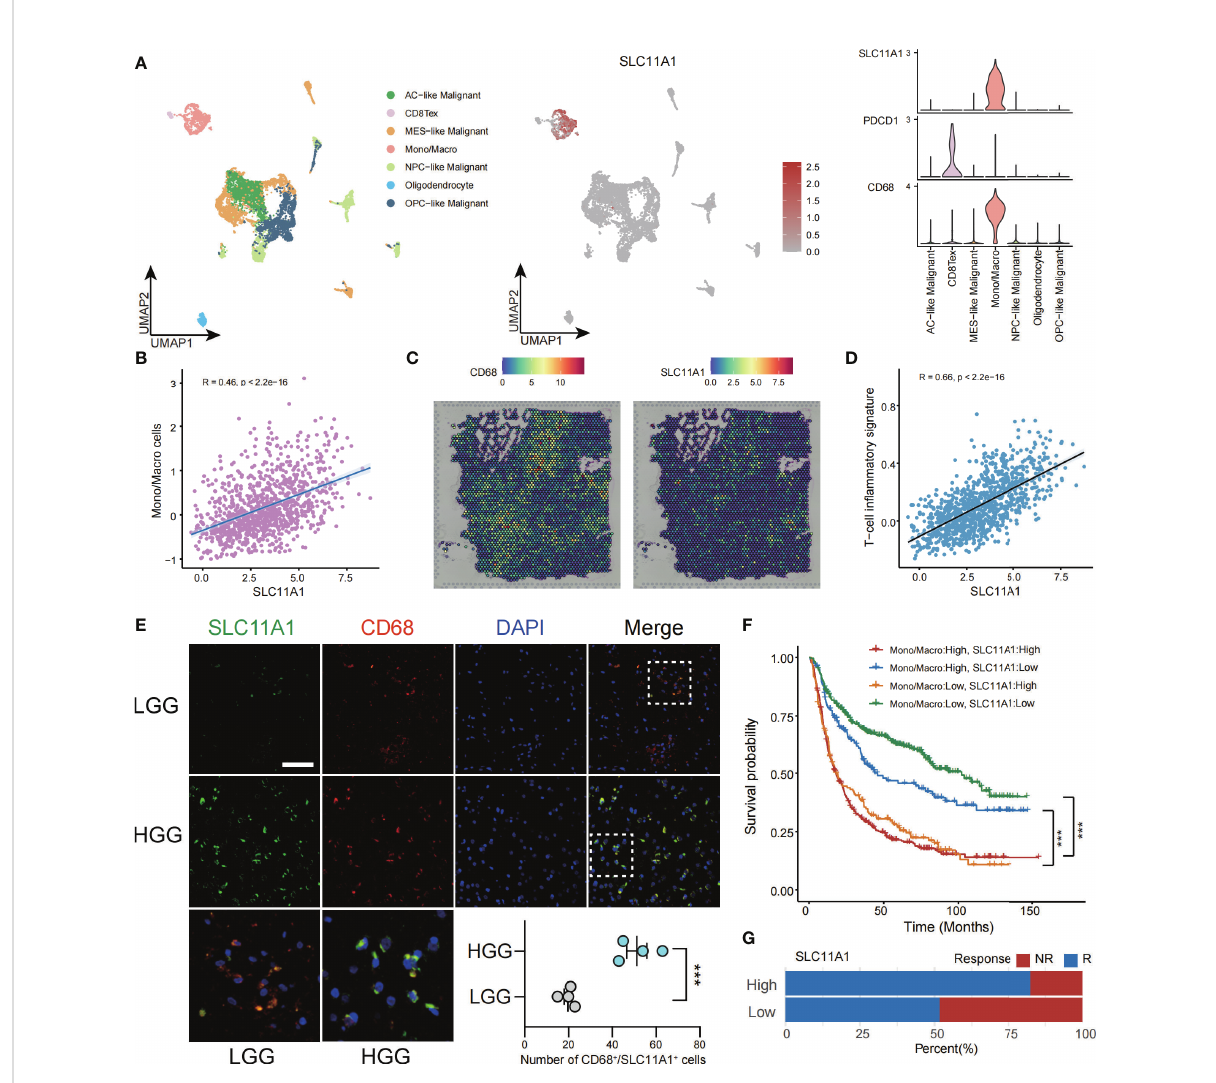
FIGURE 6 SLC11A1 expression implies TME in gliomas. (A) Analysis of immune cell in fi ltration and SLC11A1 ’ s speci fi c expression through single cell data of gliomas. (B) Correlation between the SLC11A1 ’ s expression and Mono/Macro cells (C) Analysis of SLC11A1 ’ s location in gliomas based on spatial transcriptome. (D) Correlation between the SLC11A1 ’ s expression and T-cell in fl ammatory signature. (E) Representative immuno fl uorescence images of human glioma samples co-stained with PDCD1 or CD68 (red) and SLC11A1 (green) in LGG and HGG. (F) Kaplan-Meier plots were performed in context of monocytes/macrophages in fi ltration and SLC11A1 expression. ***,P < 0.001 (Wilcoxon test). (G) Rates of anti-PD1 responses of patients from the CGGA cohort in the high or low SLC11A1 subgroups based on